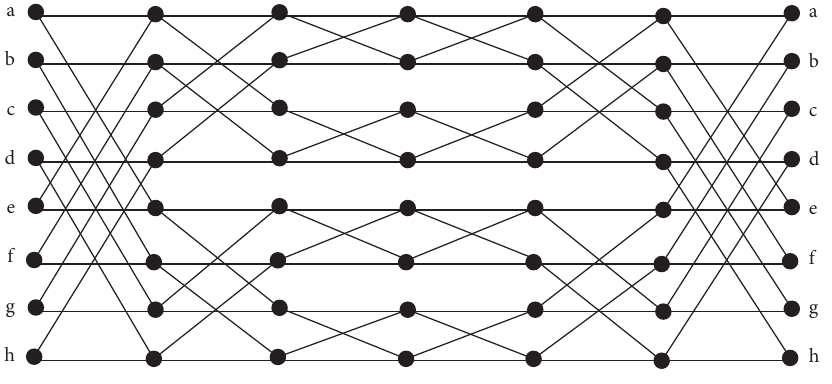
Figure 2: Normal representation of VCB ( 3 ) .